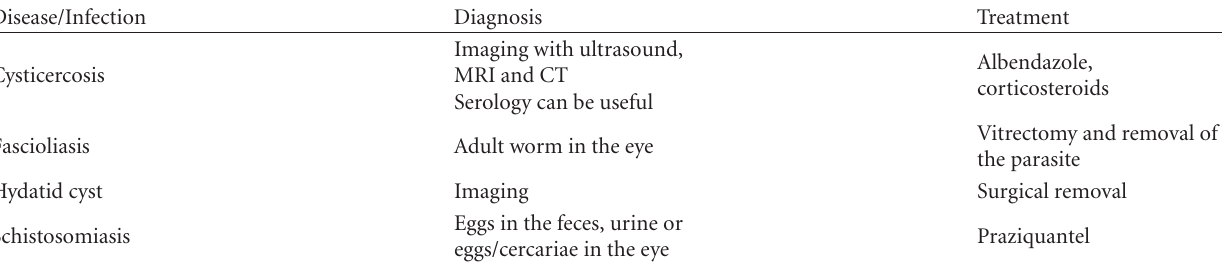
Table 6: Ocular parasitosis caused by flat worms ( diagnosis and treatment